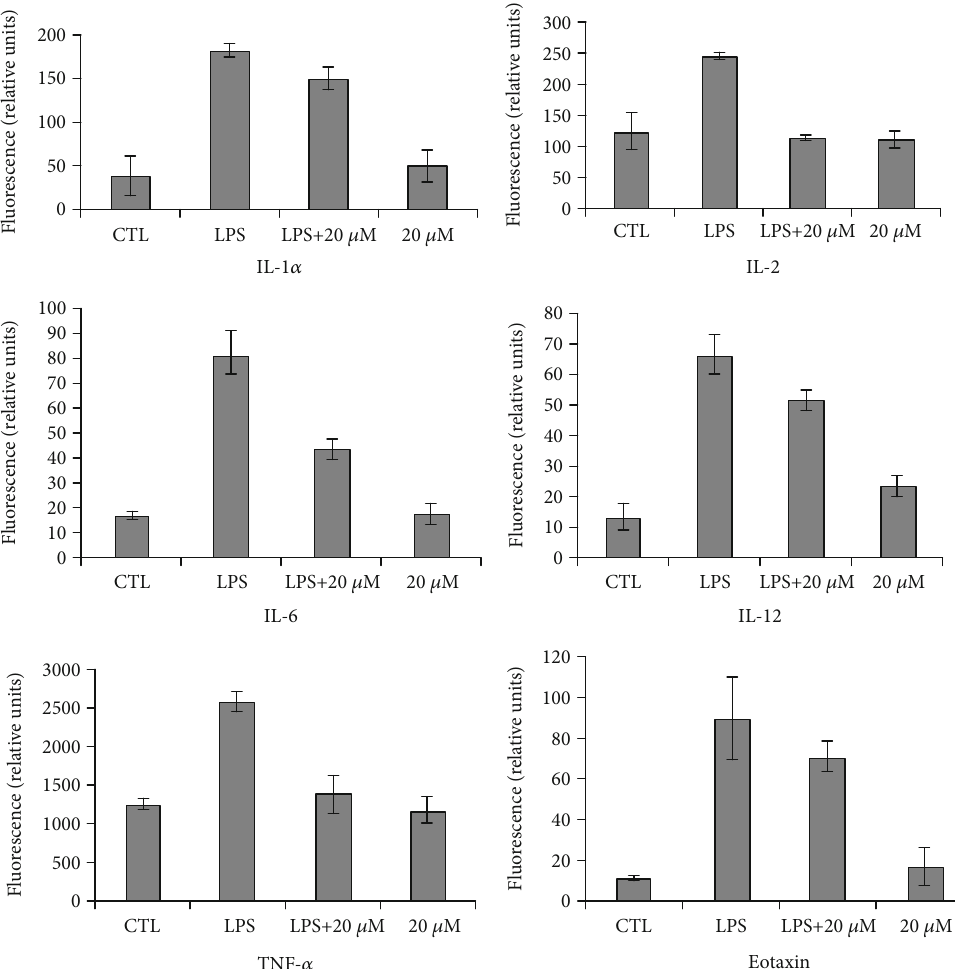
Figure 7: In fl uence of DTS on the production of in fl ammatory